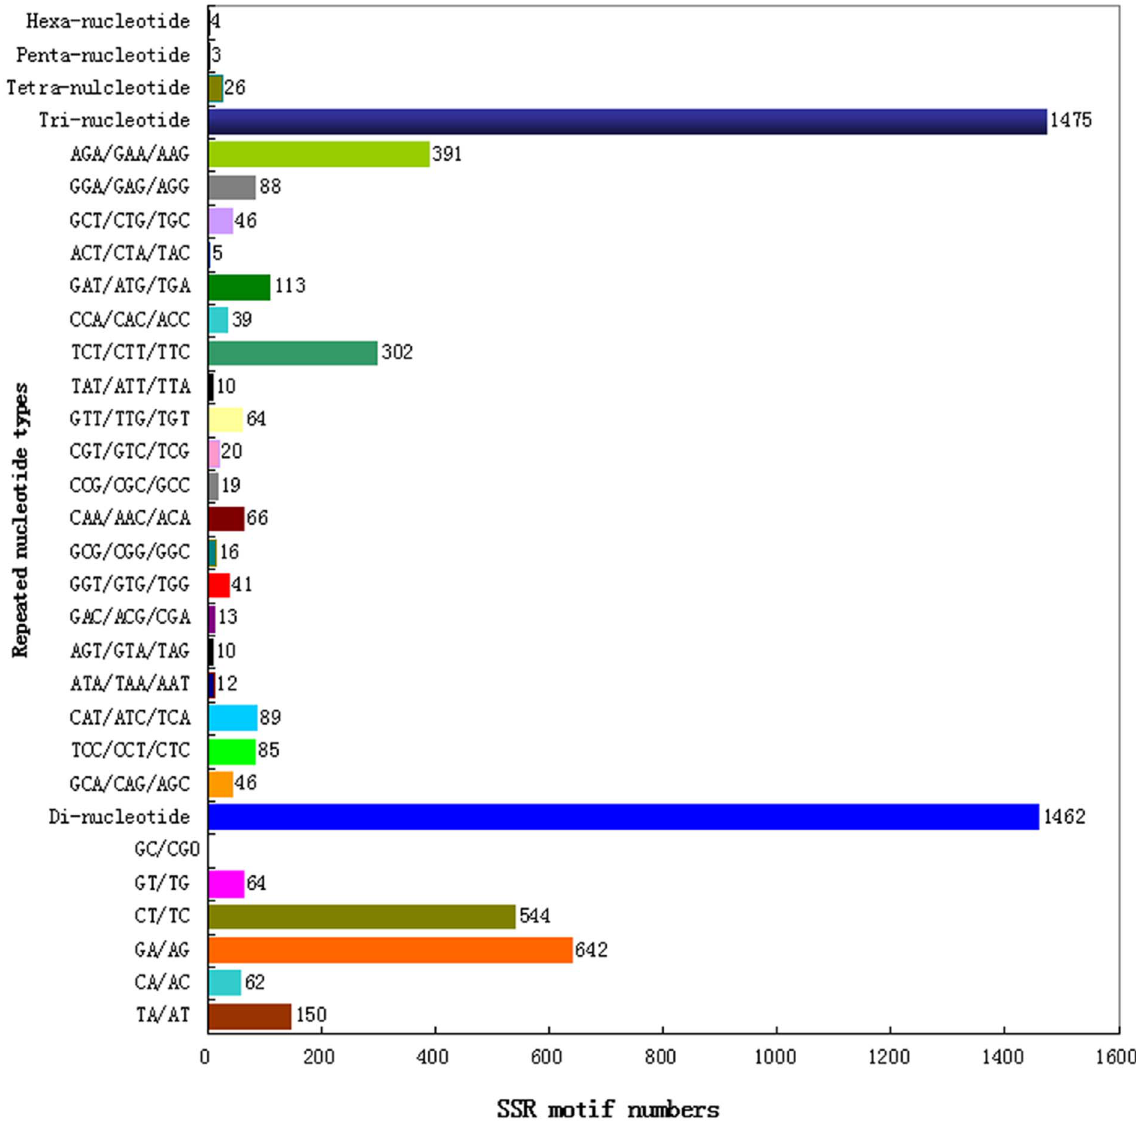
Figure 4. Distribution of different types of simple sequence repeats (SSRs) identified in the I.indigotica unigenes that are longer than 1000 bp.